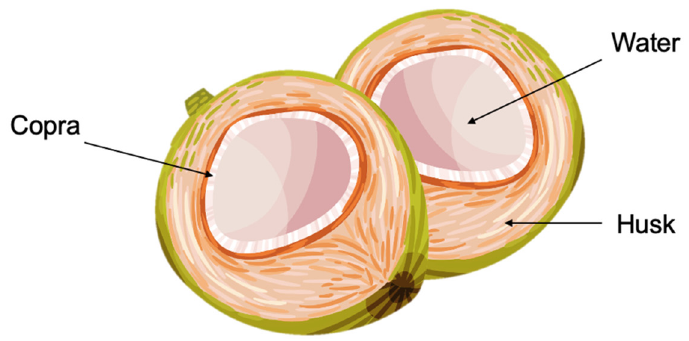
Figure 1. Parts of the coconut. Table 1. Composition of different coconut parts before and after being applied with different kinds of processing treatments. Data presented on an as-fed basis adapted from previous studies [7,13– 27].